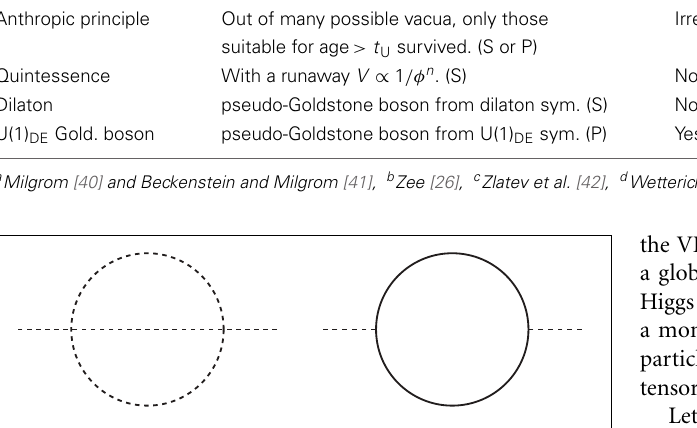
FIGURE 1 | Diagrams leading to dimension 2 interactions with dimension 4 coupling at each